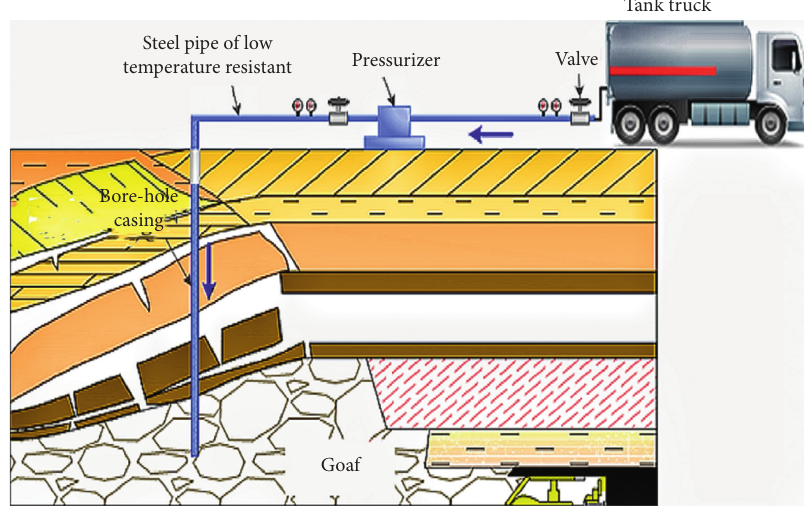
Figure 15: Schematic diagram of the proposed process for surface liquid CO